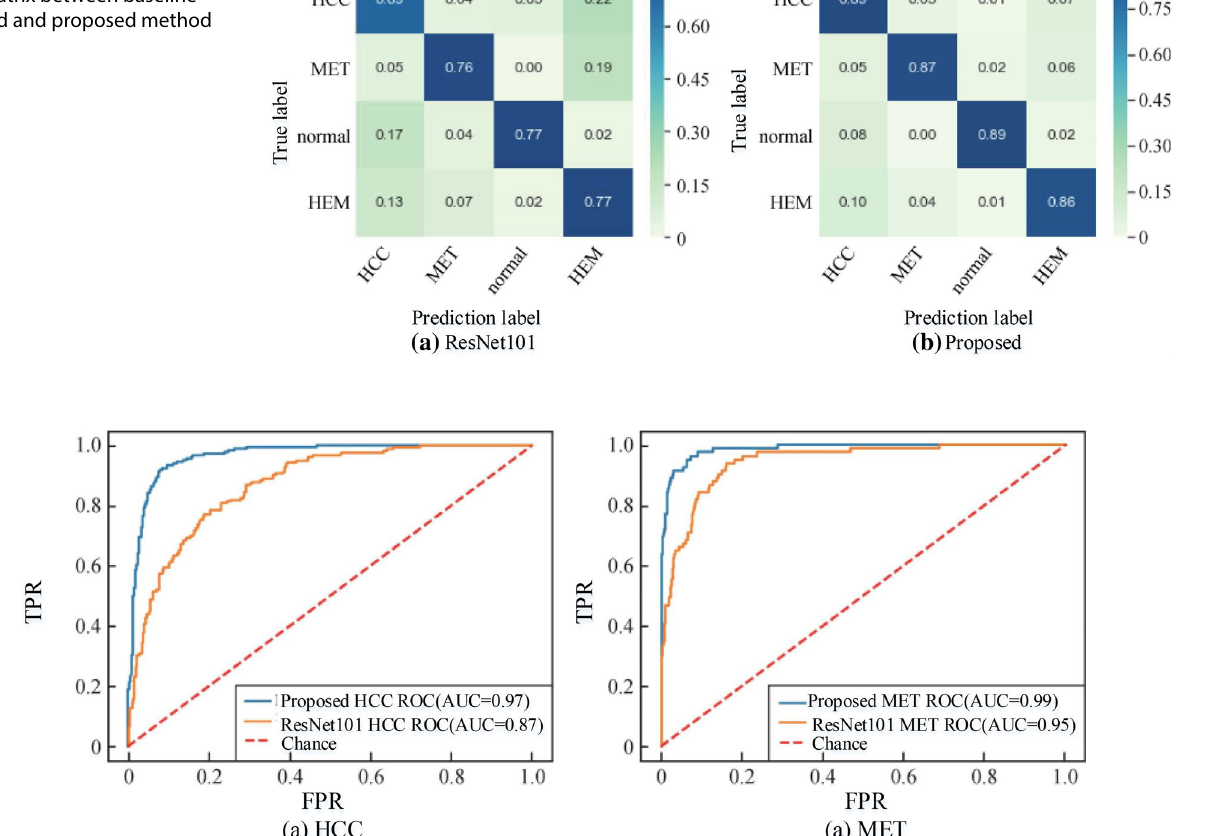
Fig. 9 Comparison of confu- sion matrix between baseline method and proposed method